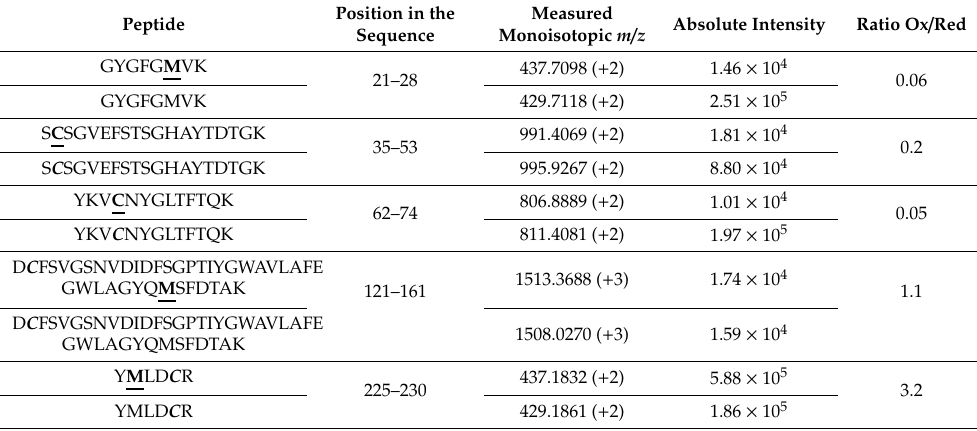
Table 3. Comparison of the absolute intensities of molecular ions of selected sulfur containing tryptic peptides found in the analysis of hVDAC3 reduced with DTT, carboxyamidomethylated, and digested